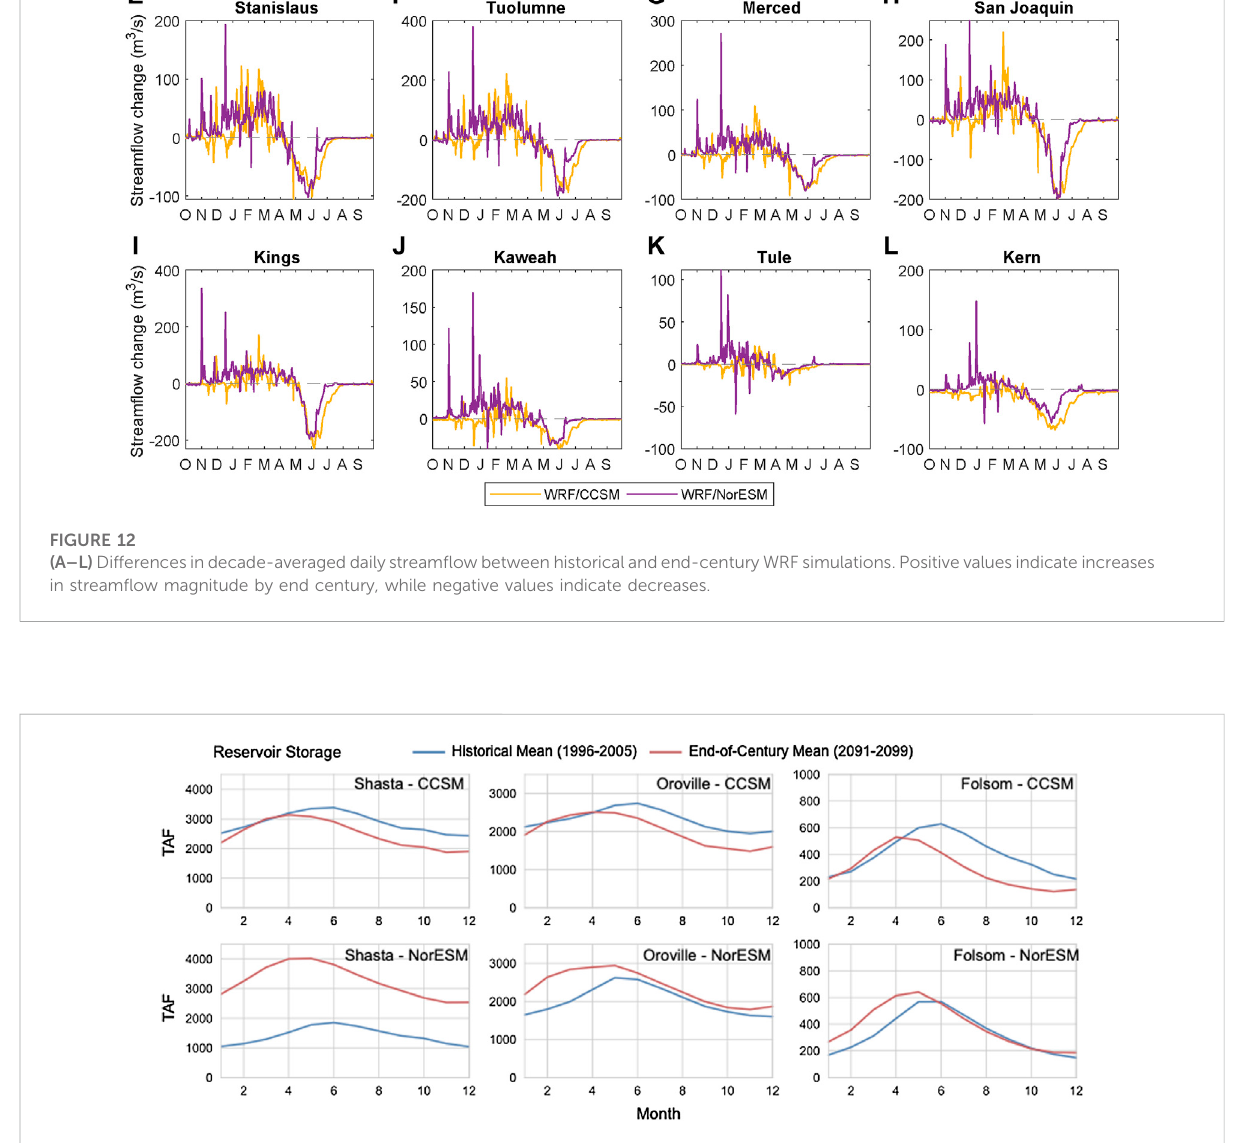
FIGURE 13 Reservoir storage, inthousand acre feet(TAF),for lakes impounded byShasta, Oroville, andFolsomDams inthefoothills of theSierra Nevada